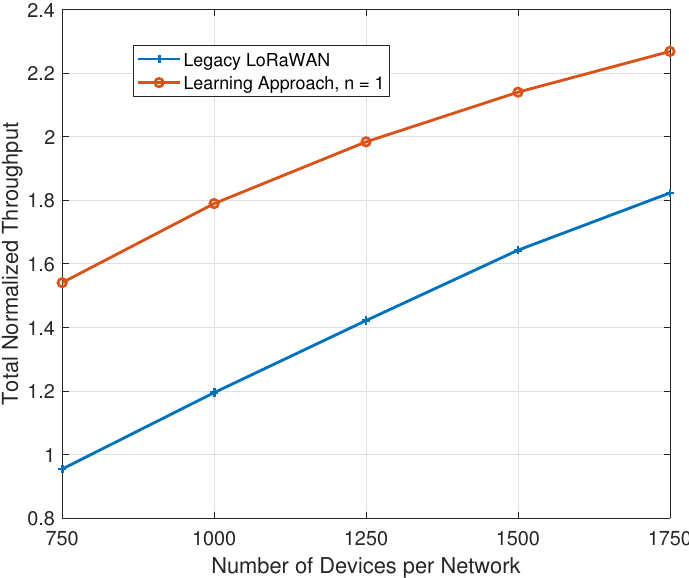
Figure 5. Impact of an increase in the number of devices on the total normalized throughput.